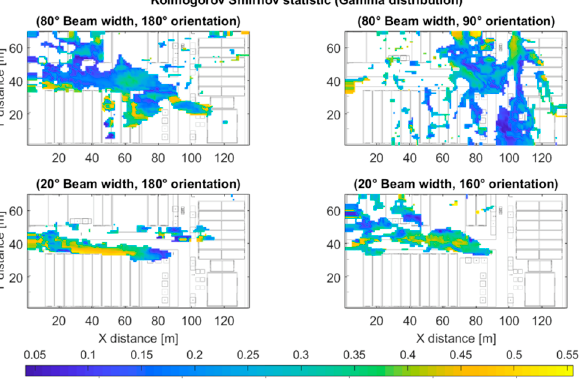
Figure 10. Kolmogorov–Smirnov statistic between the data from simulation and Nakagami distribution ( top left ), Rayleigh distribution ( top right ), Weibull distribution ( center left ), Log-normal distribution ( center right ), and Gamma distribution ( bottom ) for the outdoor scenario and different transmitter antenna configurations.